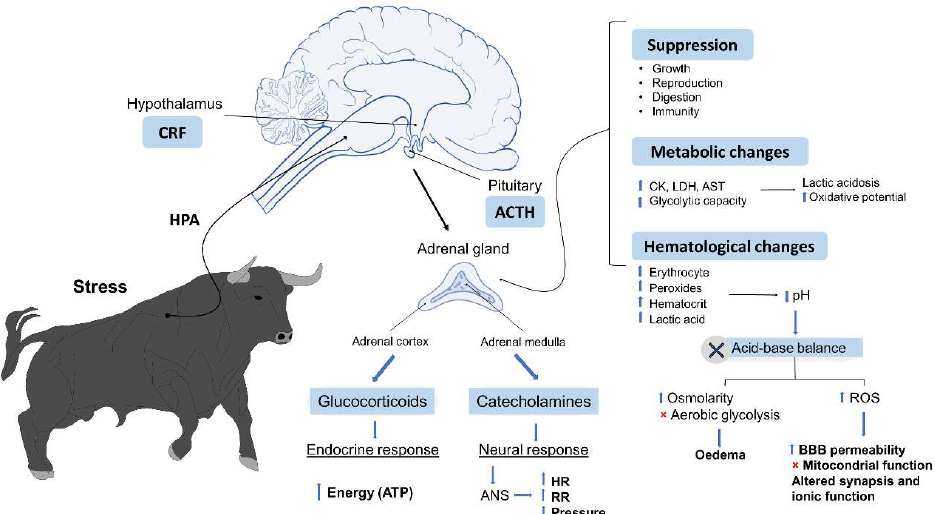
Figure 2. Metabolic, haematological, and acid–base balance alterations that occur during the endocrine response to stress and the physical effort in fighting bulls. One of the main metabolic responses that occurs during stressful conditions consists in an increase of adrenal glucocorticoids, such as cortisol, that circulate in the bloodstream [95]. In other species, it is well known that short periods of glucocorticoid release can cause irreversible damage, including reproductive disorders, immunosuppression, and reduced life expectancy [96,114,115]. In addition, the emotional stress and intense exercise that fighting bulls undergo and the exposure to a new environment during the event produce marked increases of cortisol, glucose, and T3 in the bloodstream that can generate significant biochemical changes in the organism by triggering the stress-adaptation syndrome [52]. Catecholamines function to prepare an organism for the “flight-or-fight” response but triggers tachycardia, hypertension, hyperthermia, hyperventilation, and sweating [48,116]. Cortisol begins to be secreted by the adrenal cortex around five minutes after the stressful stimulus is presented. This substance, which can be detected in blood, saliva, urine, and faeces, performs the primary function of increasing and then maintaining blood glucose levels using reserves of hepatic and muscular glycogen to provide the animal with sufficient energy to sustain the physical effort that the situation demands [117]. CRF: corticotropin releasing factor; HPA: hypothalamic-pituitary-adrenocortical axis; ACTH: adrenocorticotropic hormone; ATP: adenosine triphosphate; ANS: autonomic nervous system; HR: heart rate; RR: respiratory rate; CK: creatine kinase; LDH: lactate dehydrogenase; AST: aspartate aminotransferase; ROS: reactive oxygen species; BBB: blood–brain barrier.